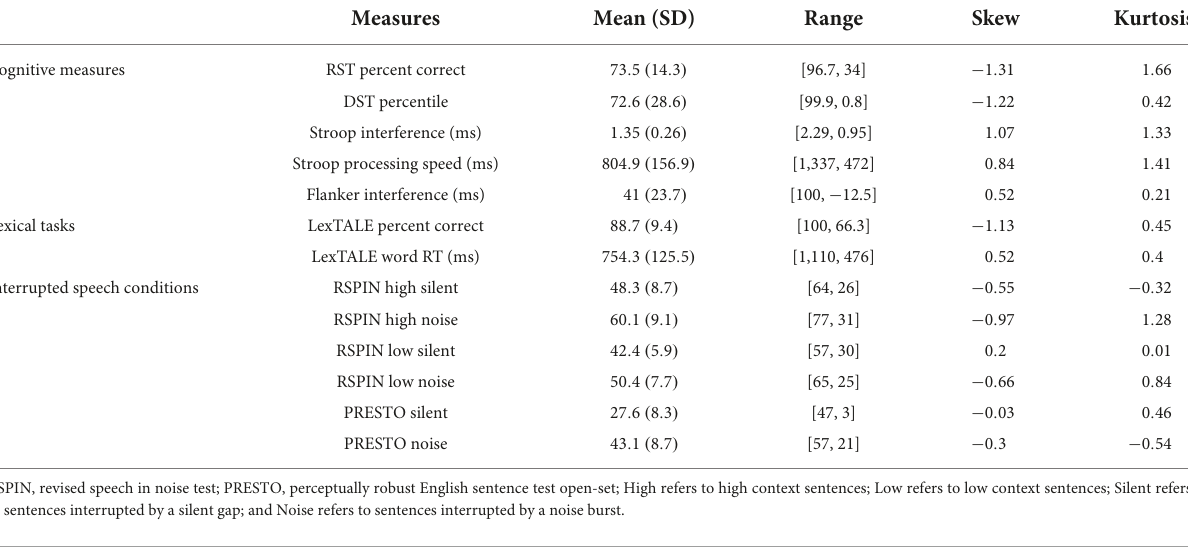
using the Stroop Interference score ( r = 0.29, p = 0.02) and processing speed measured using the Stroop word-only item reaction time, or processing speed ( r = 0.29, p = 0.02). This result is consistent with both processing speed and the calculation of inhibitory control both relying on reaction time.